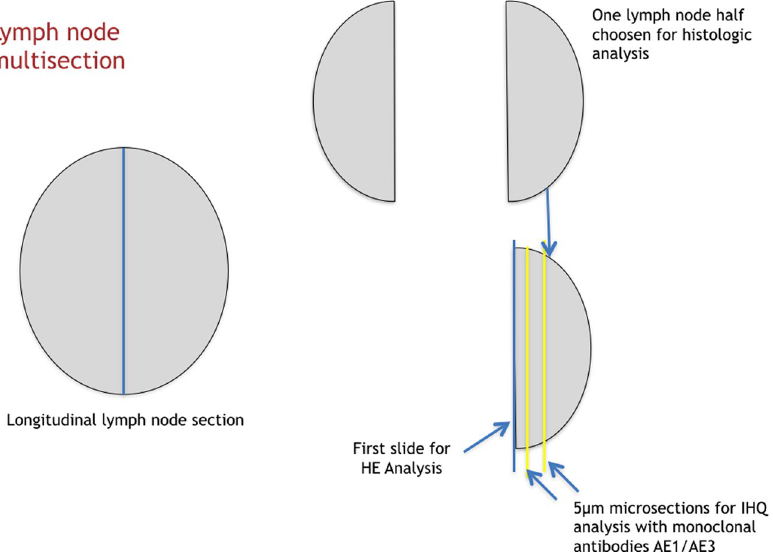
Figure 1. The multisection technique for histological and immunohistochemical analysis for lymph node